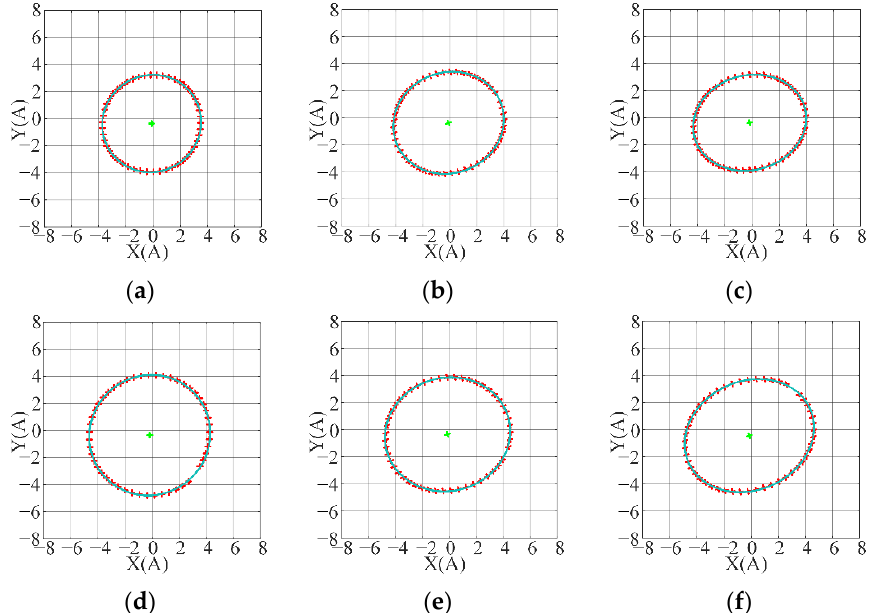
Figure 14. Experimental diagram of Park vector trajectory and its fitted ellipse: ( a ) healthy condition at 30% T N . ( b ) B and C phases in series with 1 Ω resistors at 30% T N . ( c ) B and C phases in series with 2 Ω resistors at 30% T N . ( d ) Healthy condition at 70% T N . ( e ) B and C phases in series with 1 Ω resistors at 70% T N . ( f ) B and C phases in series with 2 Ω resistors at 70% T N . Table 6. Experimental data of motor negative sequence